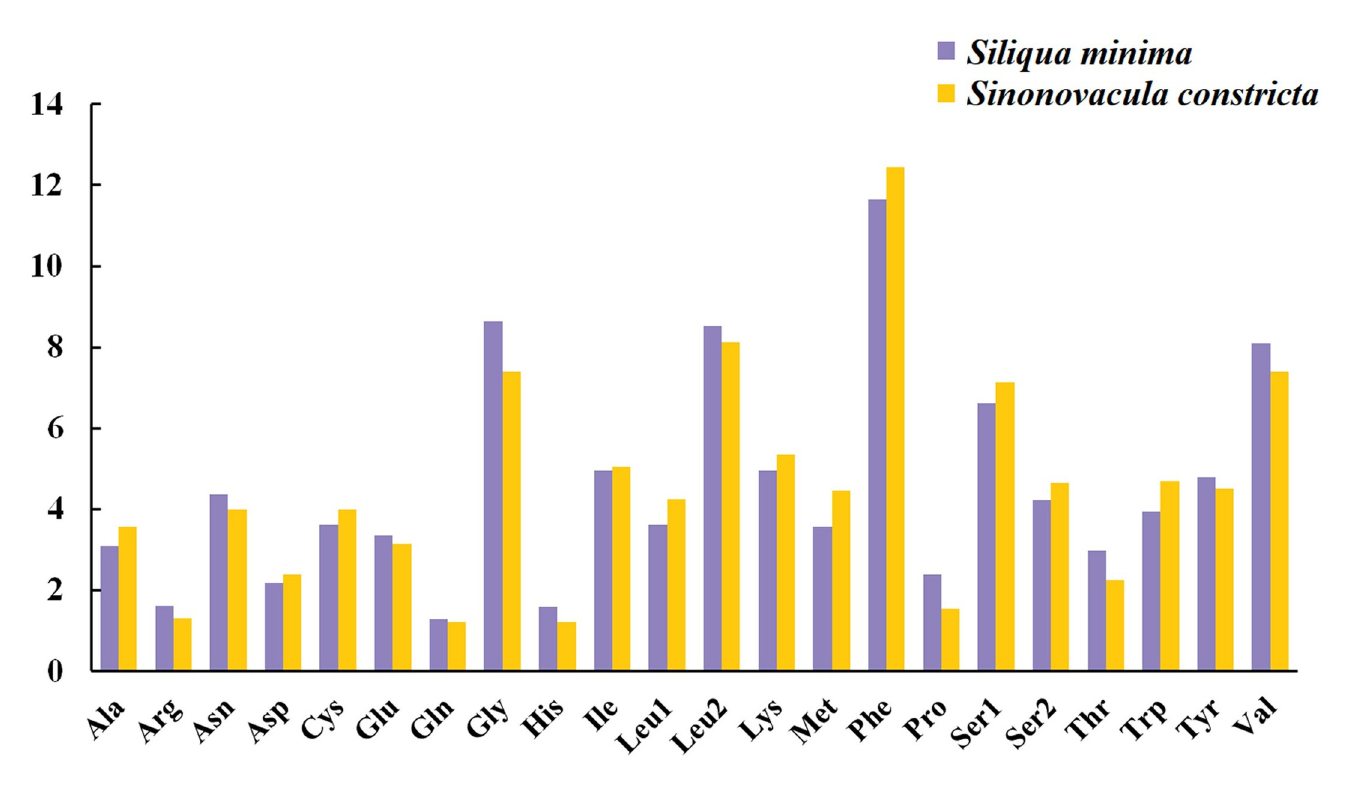
Fig 4. Amino acid composition of two Pharidae mitochondrial